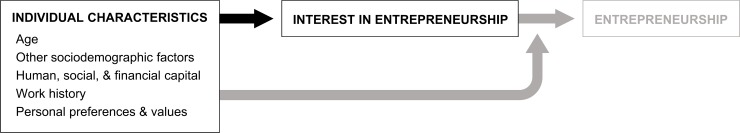
Conceptual model of entrepreneurial interest in later life.Adapted from Halvorsen & Morrow-Howell. [2]. Conceptual framework on self-employment in later life: Toward a research agenda. Work, Aging & Retirement, 3(4), 313–324, by permission of Oxford University Press.